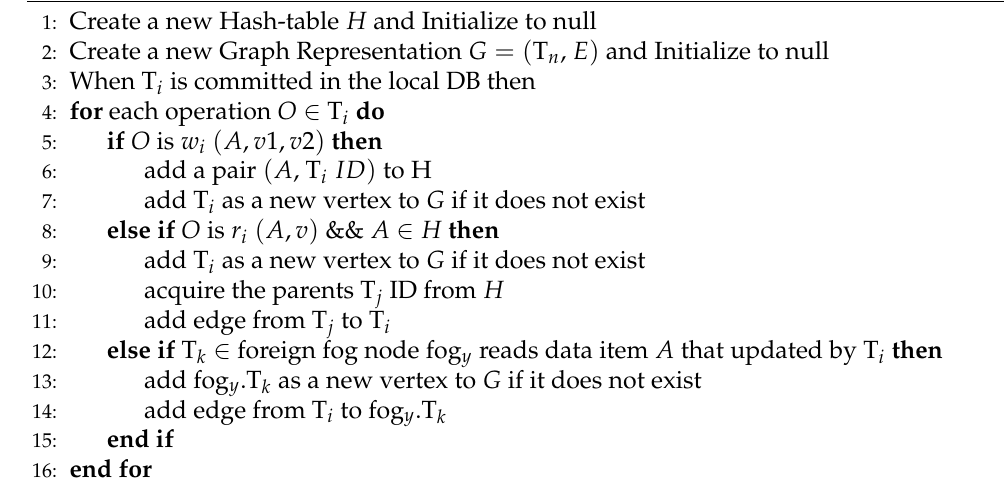
Algorithm 4 Building local graphs for public distributed fog